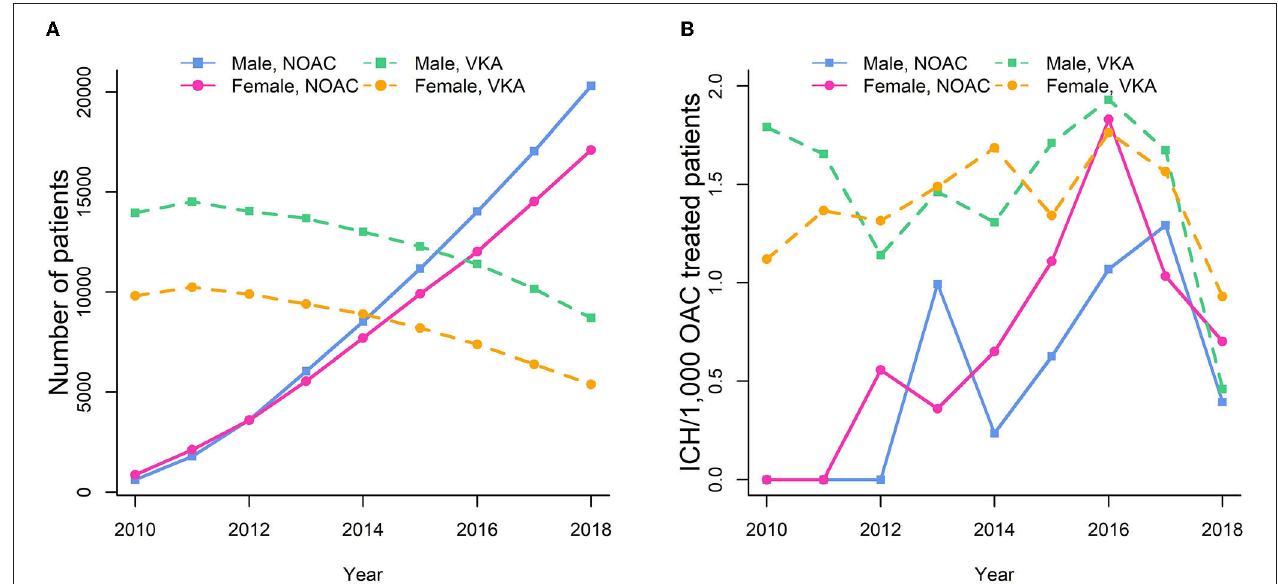
FIGURE 2 | (A) Sale of OAC by sex. (B) ICHs/1,000 patients who have presented at least one prescription within that year.